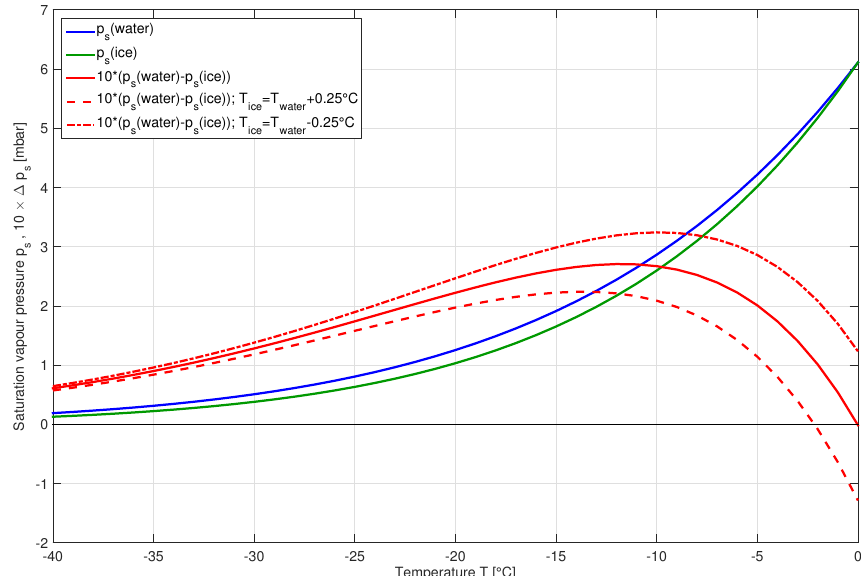
Figure 3. Saturation vapour pressures over bulk liquid water (blue curve) and ice (green curve) surfaces as a function of temperature (the parametrizations used for the saturation vapour pressures over water and ice are based on Lowe and Ficke, 1974). The difference (multiplied by a factor of 10) in the saturation vapour pressures of water and ice is given by the red curve. The difference (multiplied by a factor of 10) in the saturation vapour pressures of water and ice when the ice temperature ( T ice ) is 0 . 25 ◦ C higher and lower than the water temperature ( T water ) is given by the dashed and dotted red lines